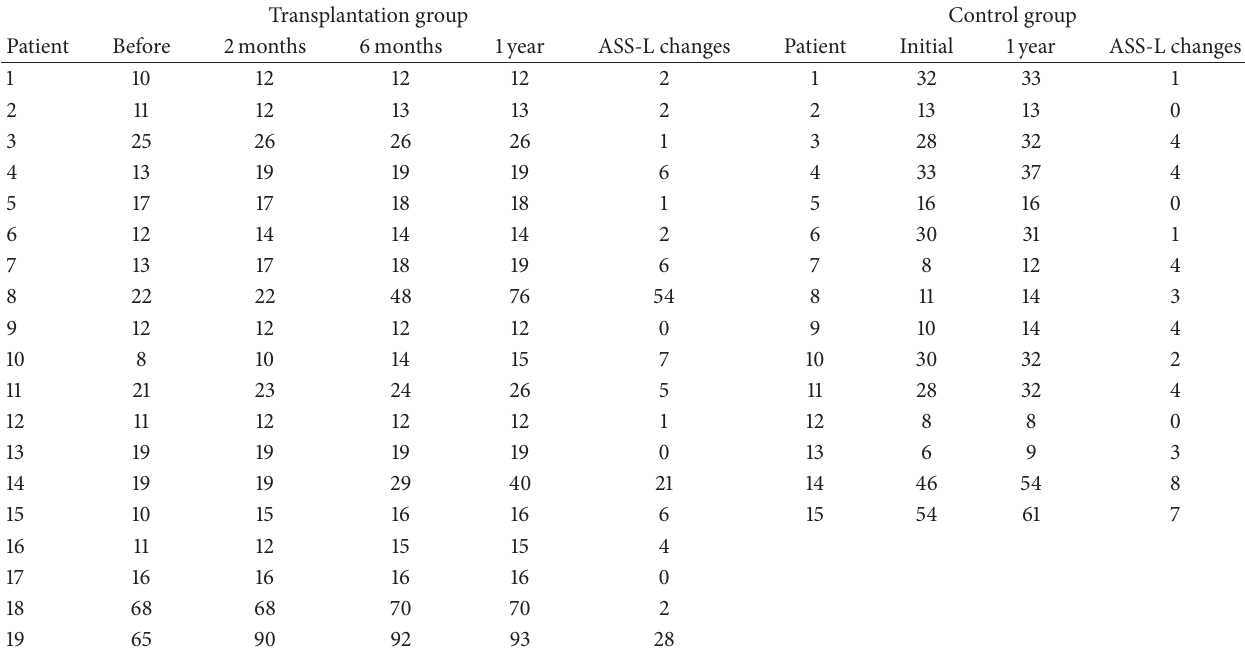
Table 9: ASS-light touch (ASS-L).